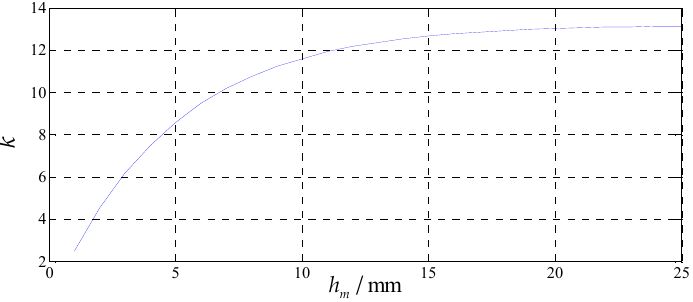
Figure 8. Force coefficient k curve with respect to the thickness of permanent magnet.